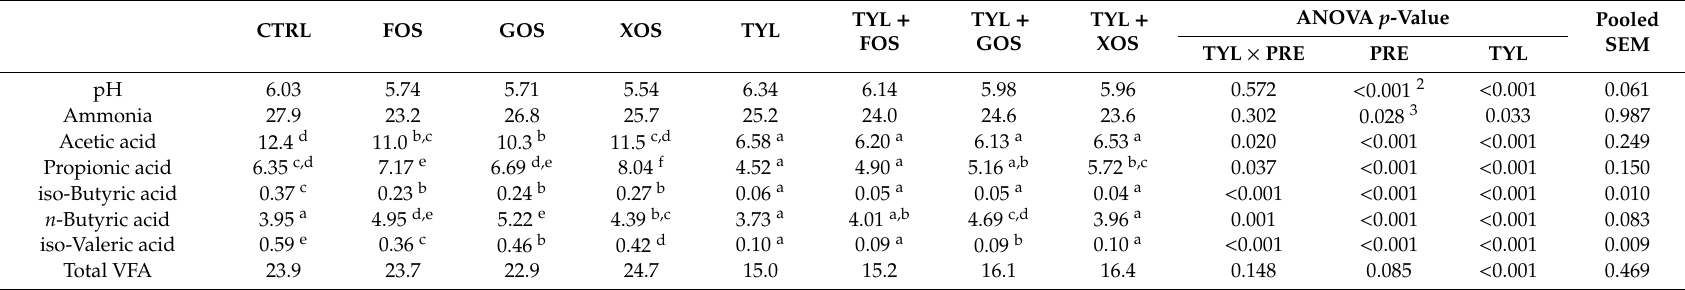
Table 1. pH values and concentrations (mmol / L) of ammonia and volatile fatty acids after 6 h of an in vitro incubation of canine fecal inoculum with a control diet supplemented with some prebiotics and / or tylosin tartrate 1 .